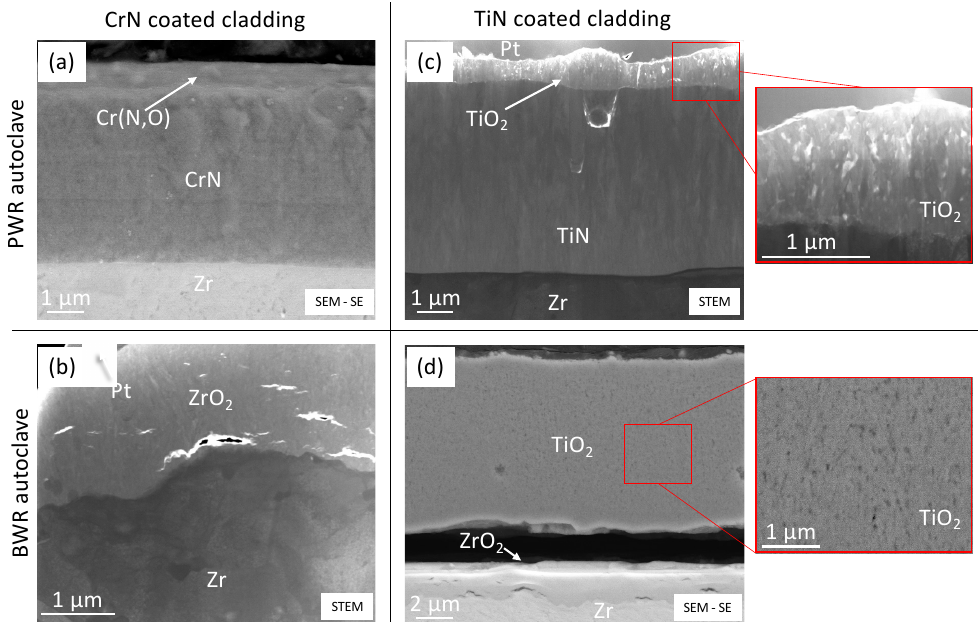
Figure 2. SEM and STEM cross-sectional images of the outer surfaces of the coated claddings after autoclave exposure. ( a ) SEM image of CrN-coated cladding after PWR autoclave exposure; ( b ) STEM image of CrN-coated cladding after BWR autoclave exposure; ( c ) STEM image of TiN-coated cladding after PWR autoclave exposure; ( d ) SEM image of TiN-coated cladding after BWR autoclave exposure.